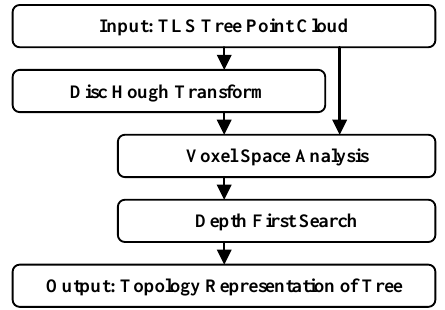
Figure 2. Processing scheme outline for topology